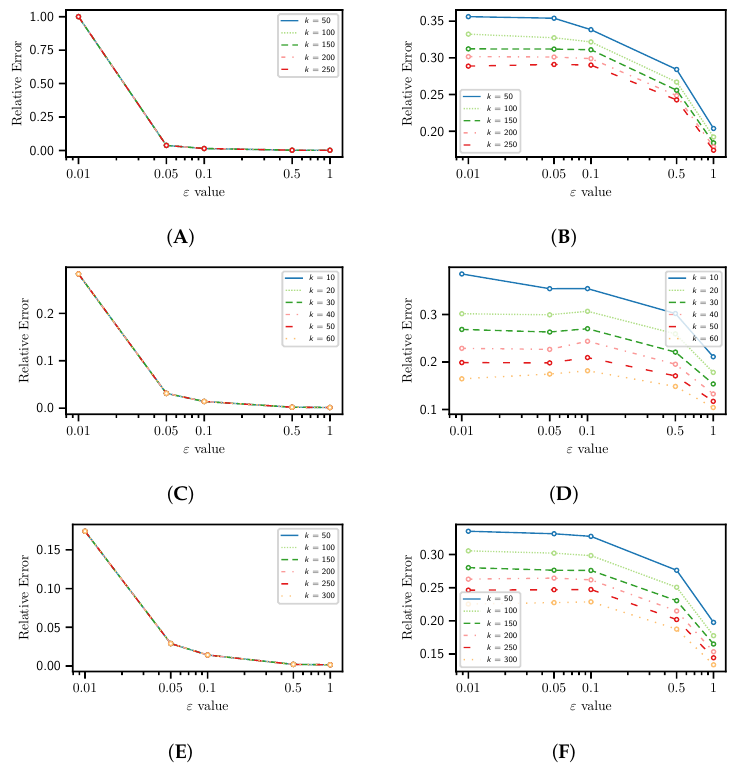
Figure 2. Information loss measured as the relative error. Where ( A ) DP-FSM Bank, ( B ) Graph-based Bank, ( C ) DP-FSM German, ( D ) Graph-based German, ( E ) DP-FSM NYC, and ( F ) Graph-based